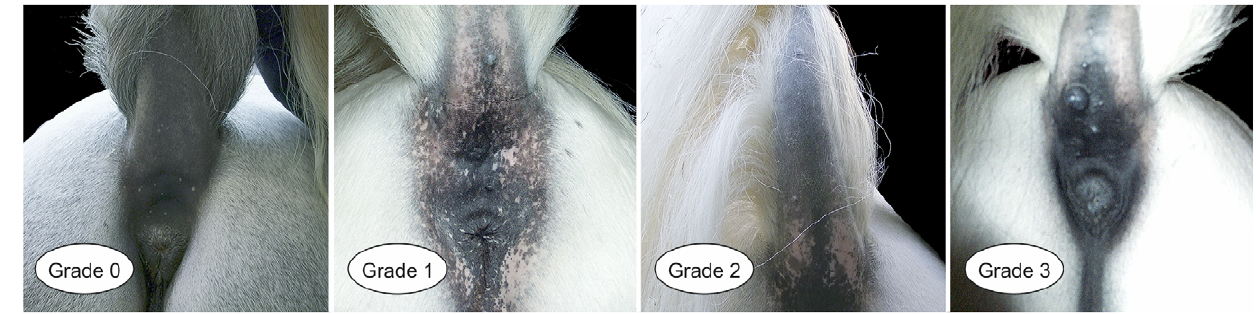
Figure 2. Variation of melanoma grade in four grey Lipizzan horses.